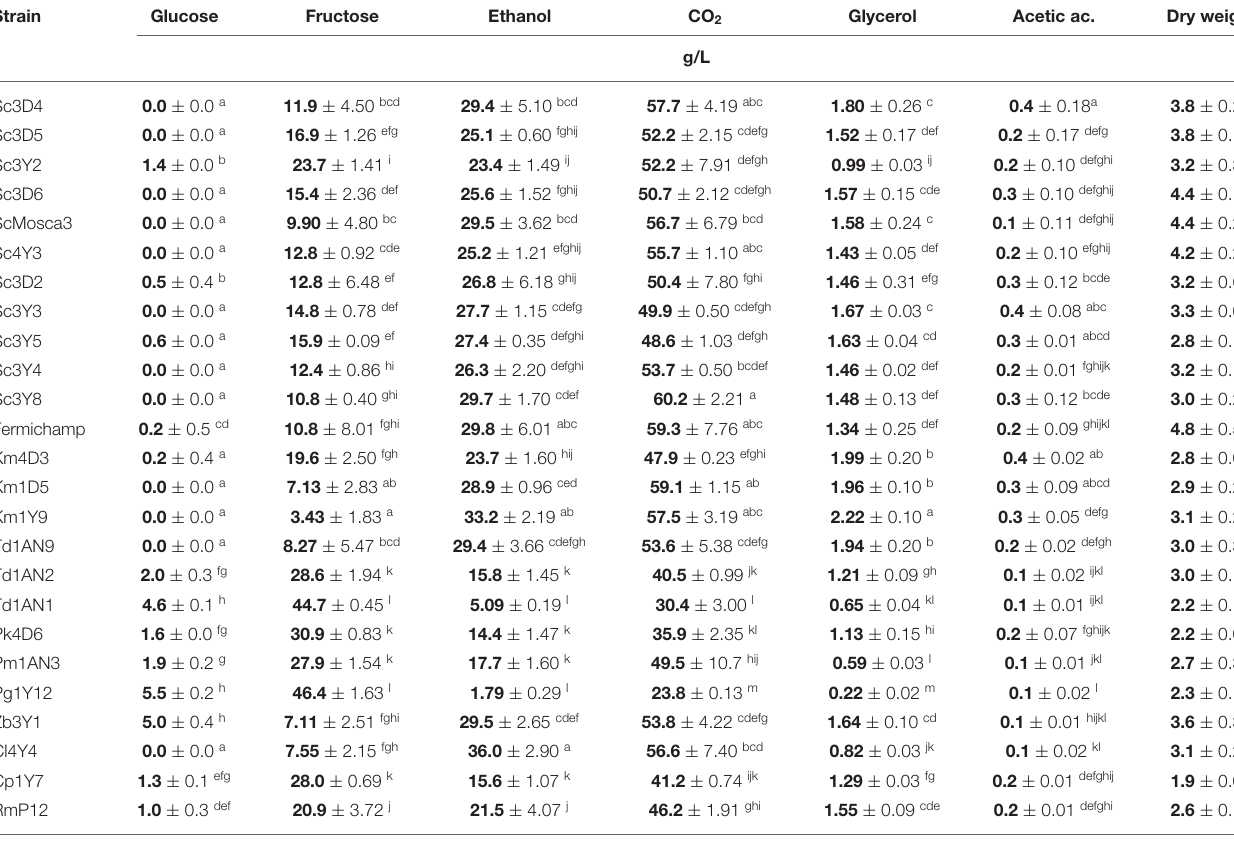
TABLE 1 | Primary metabolite production and residual hexoses for all yeasts strains tested at 48h of fermentation in semi-synthetic medium M2. Strain Glucose Fructose Ethanol CO 2 Glycerol Acetic ac.